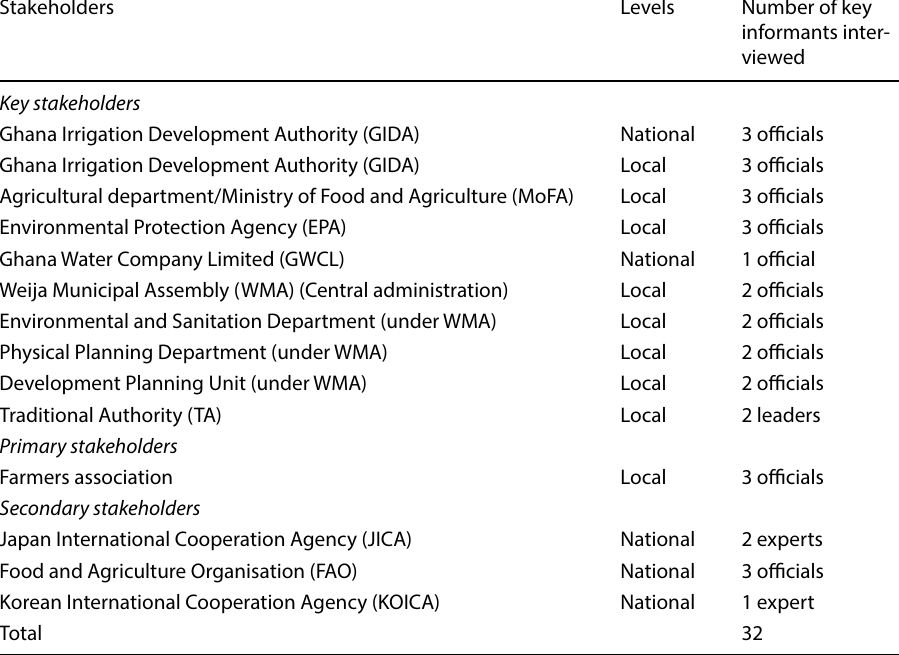
Table 3 List of interviewees and their affiliation. Source Developed by the